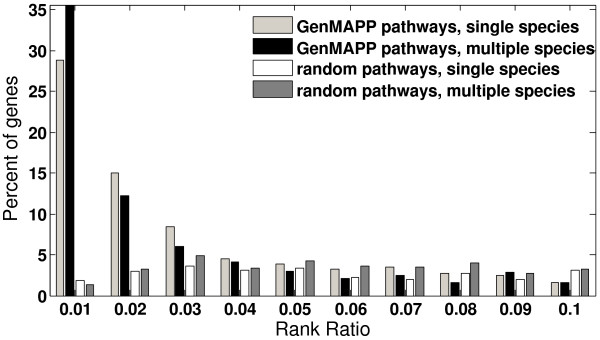
The MSGR ranks pathway genes higher than genes from random pathways. Each bin counts the percent of genes belonging to a pathway that sorted to a particular position in the search ordering. A rank-ratio of 0.10 is equivalent to the 90th percentile; a rank-ratio of 0.01 is equivalent to 99th percentile. Bars correspond to GenMAPP pathways run through single-species PMT nodes (dark gray) or multiple-species ancestral PMT nodes (black) and to random pathways run through single-species nodes (white) or multiple-species ancestral nodes (light gray).